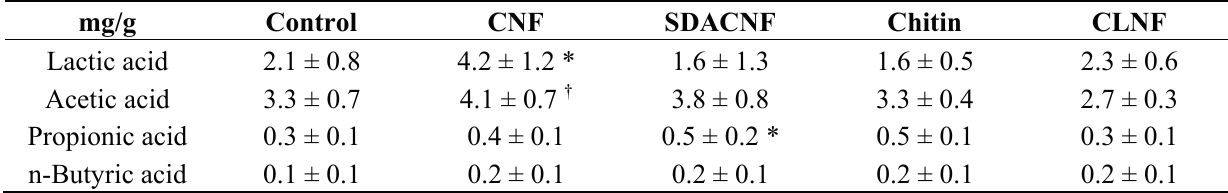
Table 4. Effects of oral administrations of chitin nanofibers (CNFs) and surface-deacetylated (SDA) CNFs on fecal short chain fatty acid (FA) levels. mg/g Control CNF Chitin CLNF Lactic acid Acetic acid Propionic